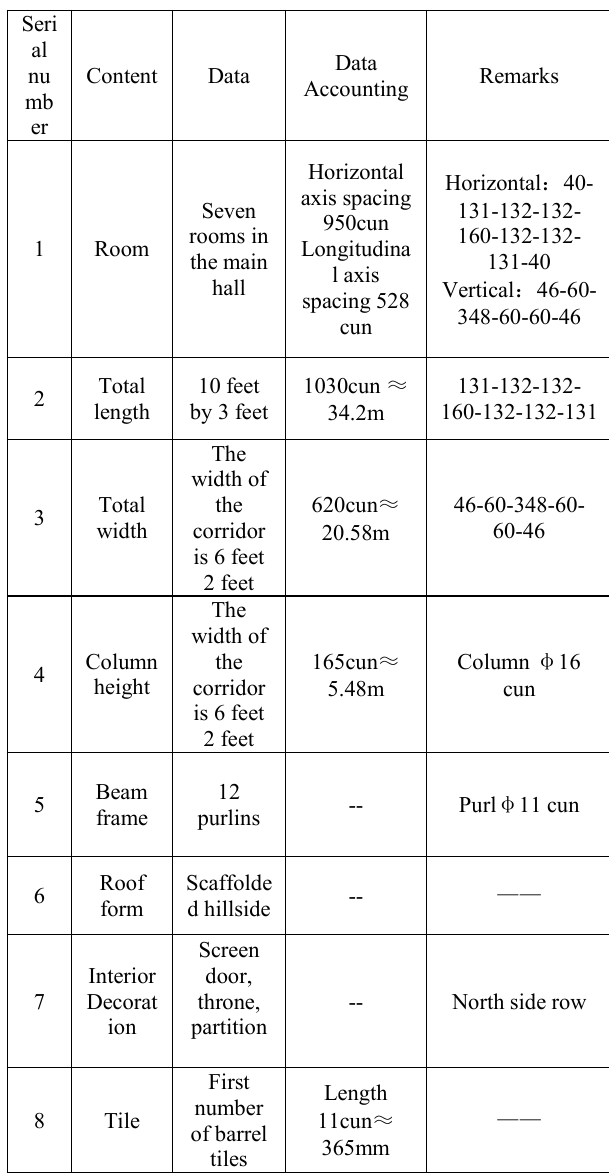
extrapolated for digital recovery data to improve and supplement the database